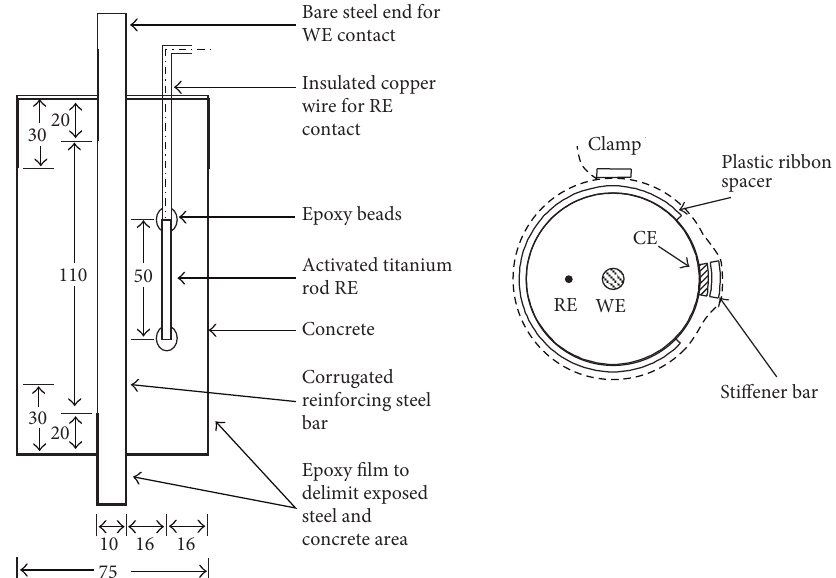
F 2: �chematic showing the cell con�guration according to